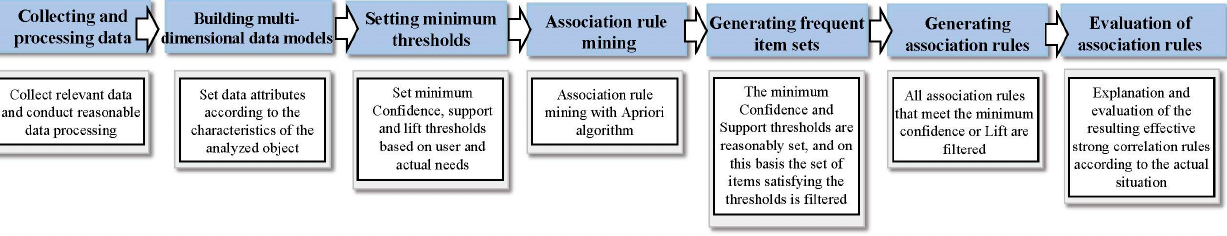
Figure 1. Steps for association rule mining by the Apriori algorithm.